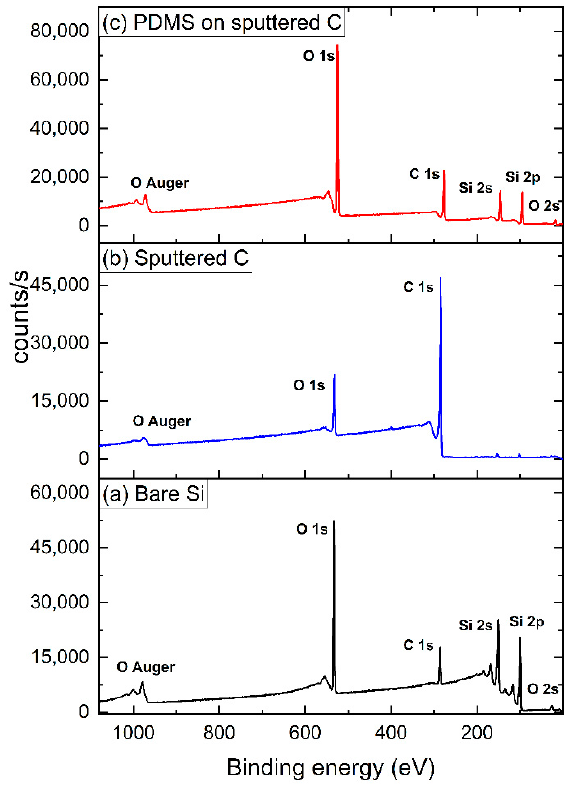
Figure 2. XPS survey scans of ( a ) a bare silicon surface, ( b ) a silicon surface coated with sputtered carbon, and ( c ) a sputtered carbon surface after PDMS deposition.